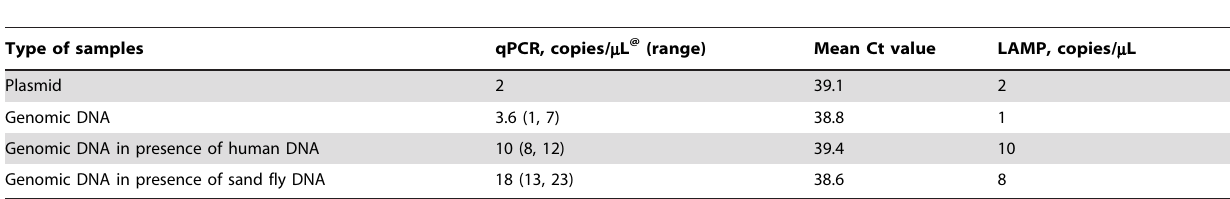
Table 2. Detection limit of the LAMP assay compared to qPCR targeting different types of known positive samples for B.